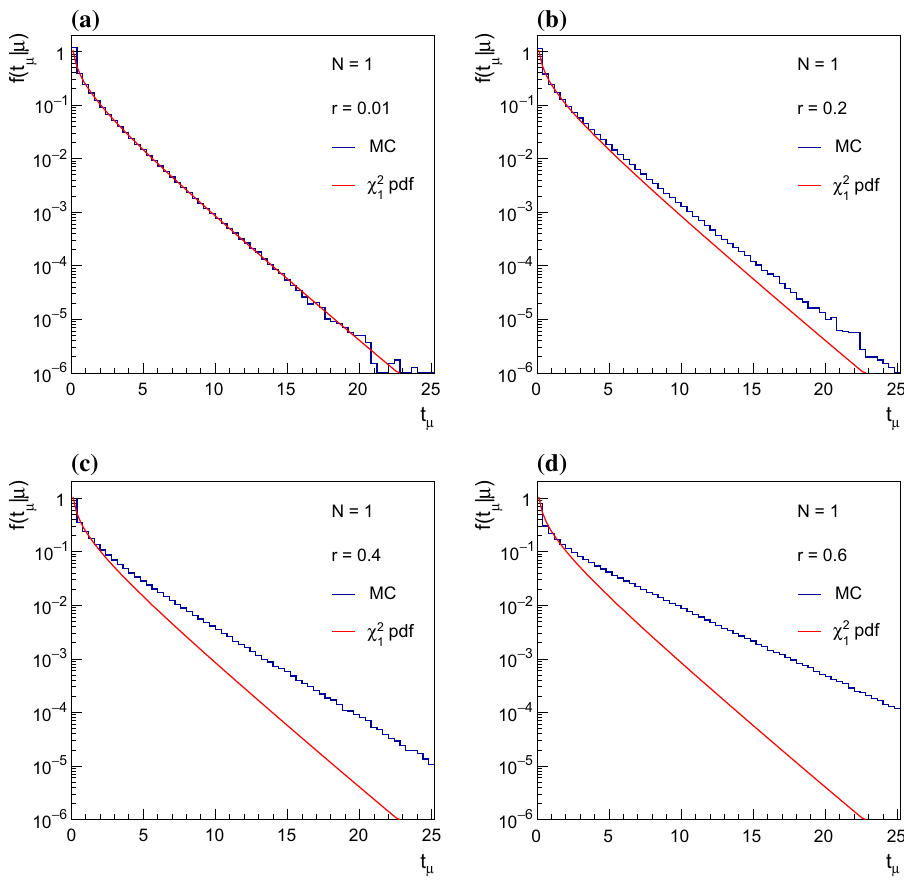
Fig. 2 Distributions of the test variable t μ for a single Gaussian distributed measurement with relative error-on-error